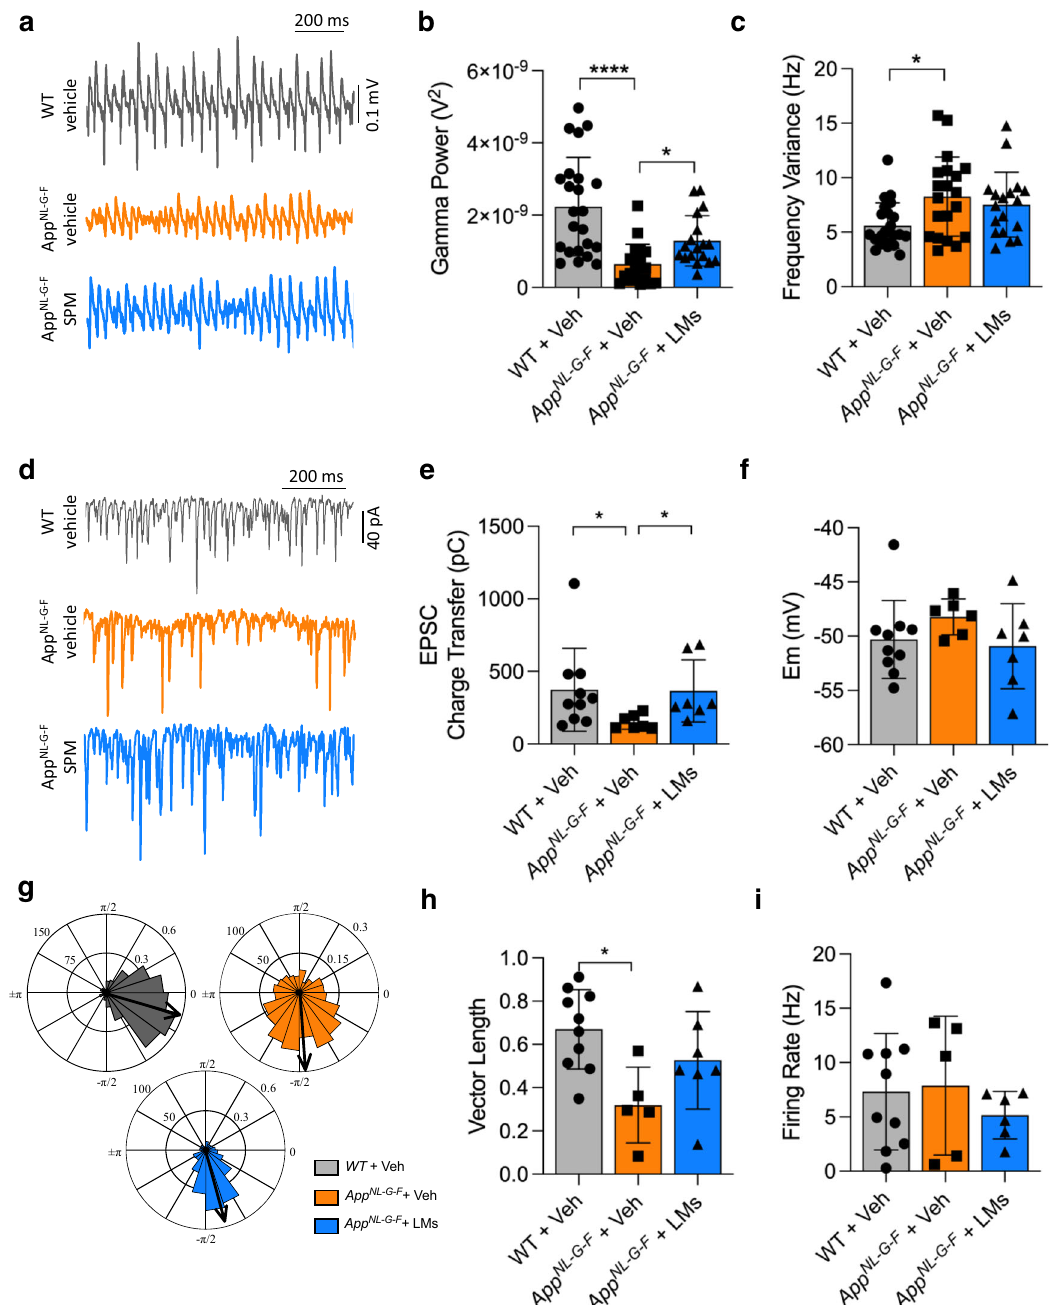
Fig. 2 LMs partially restore gamma oscillation power and synchronization in App NL-G-F mice. a Representative traces of gamma oscillations in hippocampal brain slices are shown in wild-type (WT) and App NL-G-F mice given vehicle (Veh) and App NL-G-F mice treated with lipid mediators (LMs). b Bar graphs of the gamma oscillation power in the three animal groups. Treatment with LMs partially restored the reduced gamma power observed in App NL-G-F mice. c Bar graphs of gamma oscillations described in b . There was an increase in frequency variance in the App NL-G-F mice, but the LM treatment did not reduce this. d Representative traces of excitatory postsynaptic currents (EPSCs) from fast-spiking interneurons (FSNs) in each condition. e Bar graphs showing EPSC charge transfer in FSNs from each condition. Treatment with LMs restored the reduction in EPSC charge transfer observed in App NL-G-F mice. f Bar graphs of FSN membrane potential (Em) from each condition. There was no difference in the Em between the three groups. g Polar-plots showing the distribution of AP phase-angles from the experimental conditions described in A. h Bar graphs of resulting vector length derived from concomitant recordings of gamma oscillations and FSN (AP) distribution for each experimental condition. There was a decrease in the vector length in the App NL-G-F mice, but the LM treatment did not restore this. i Bar graphs of FSN fi ring rate obtained from H. Kruskal-Wallis and one-way ANOVA tests were used for group comparisons. Data are presented as mean ± S.E.M. * P < 0.05, ** P < 0.01, *** P <